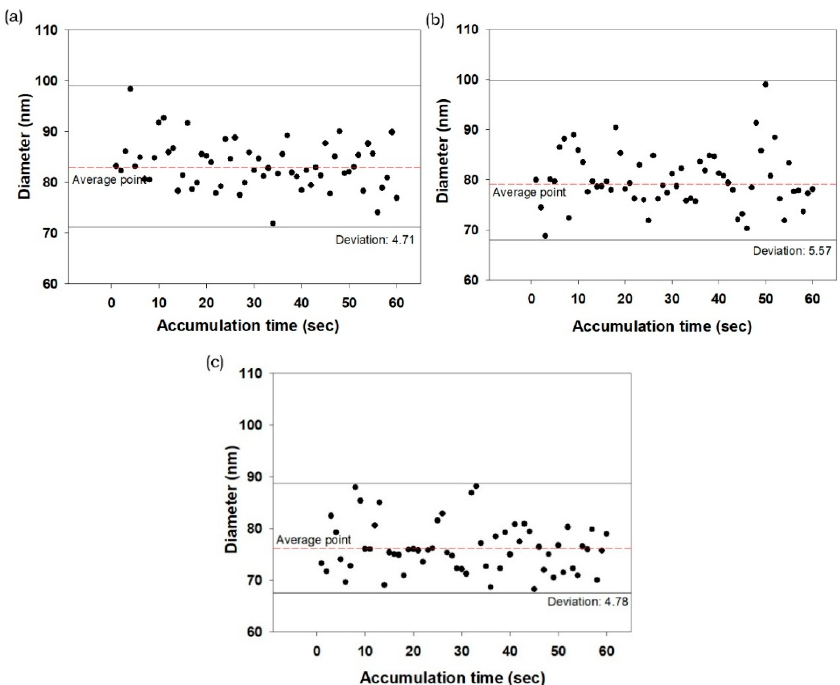
Figure 7. Results of particle size analysis during high-pressure dispersion at 1035 × 10 5 Pa. ( a ) Overall particle size as function of time. Diameter distribution after ( b ) one dispersion pass as a function of time, ( c ) two dispersion passes as a function of time.